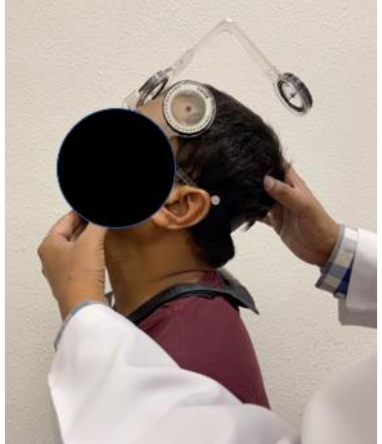
Figure 1. Cervical joint position sense evaluation using a CROM